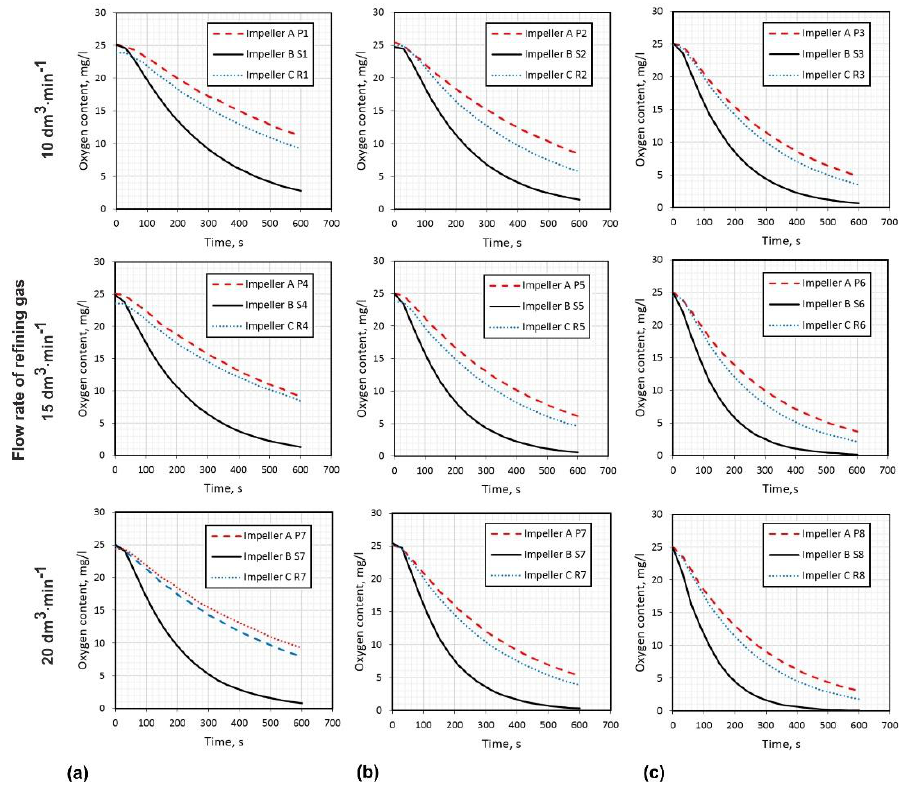
Figure 7. Results of research concerning oxygen removal from water model of batch reactor for aluminum refining, by argon blowing, for three different impellers. Flow rate of refining gas ranging from 10 to 20 dm 3 ·min −1 and: ( a ) rotary impeller speed 5.00 s −1 ; ( b ) rotary impeller speed 6.66 s −1 ; ( c ) rotary impeller speed 8.33 s −1 .